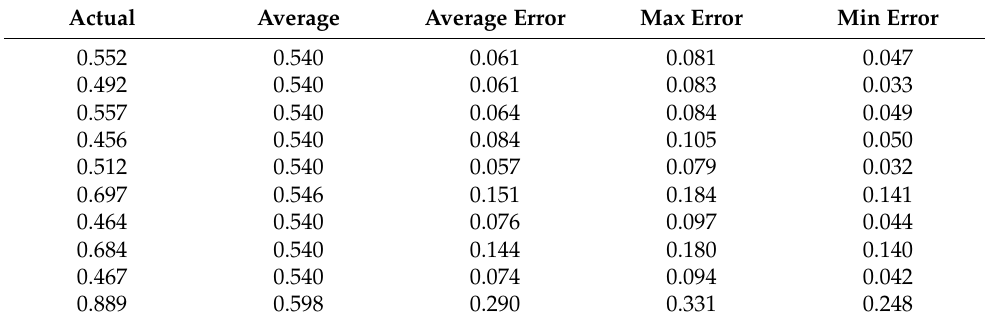
Table A48. Set 1, trials 31–40 data (actual PR value).